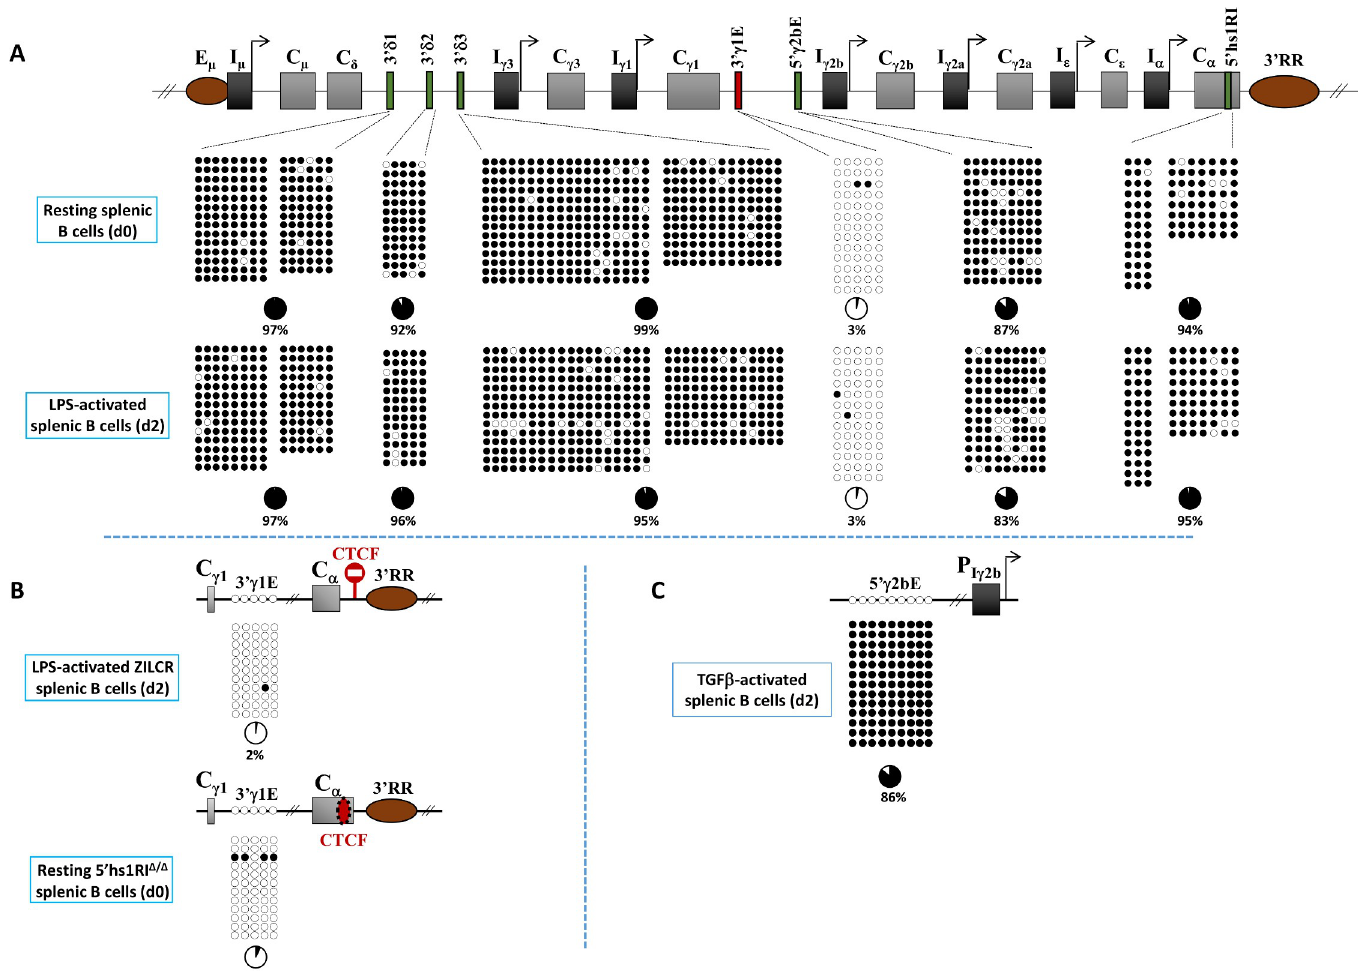
Fig 3. DNA methylation patterns of different cis -acting elements of the IgH constant locus in resting and activated splenic B cells. (A) Top. Scheme of the IgH constant locus depicting the relative position of the mapped elements, in red (3’ γ 1E) and in green (3’ δ 1, 3’ δ 2, 3’ δ 3, 5’ γ 2bE and 5’hs1RI) (see text for details). Bottom. Bisulphite sequencing assays were performed on genomic DNAs from purified WT resting splenic B cells (d0, top panels) and from activated splenic B cells (d2 post-LPS stimulation, bottom panels). (B) The hypomethylated state of the 3’ γ 1E is not affected by ectopic insulation of the 3’RR (top panel) or by deletion of the endogenous 5’hs1RI insulator. (C) The hypermethylated state of the 5’ γ 2bE does not vary upon TGF β stimulation (compare with LPS stimulation in (A)). The 9 CpGs coincide with the DNaseI hypersensitive site (see text for details), and are right upstream of the 5 CpGs shown in Figs 1 and 2, which illustrates the hypermethylated state of the region upstream of I γ 2b (see S2 Fig and S2 Table for the localization of, and the distance between, the sequenced CpGs).